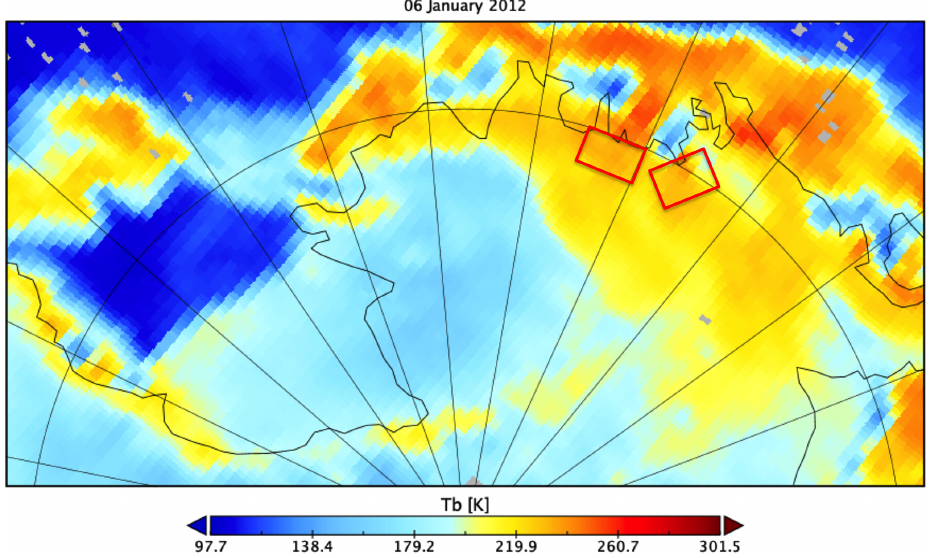
Figure B2. SSMIS horizontally polarized 19.35GHz brightness temperature over West Antarctica and the RIS on 6 January 2012, with red boxes denoting the Thwaites Glacier (left) and Pine Island Glacier (right) bounding regions.